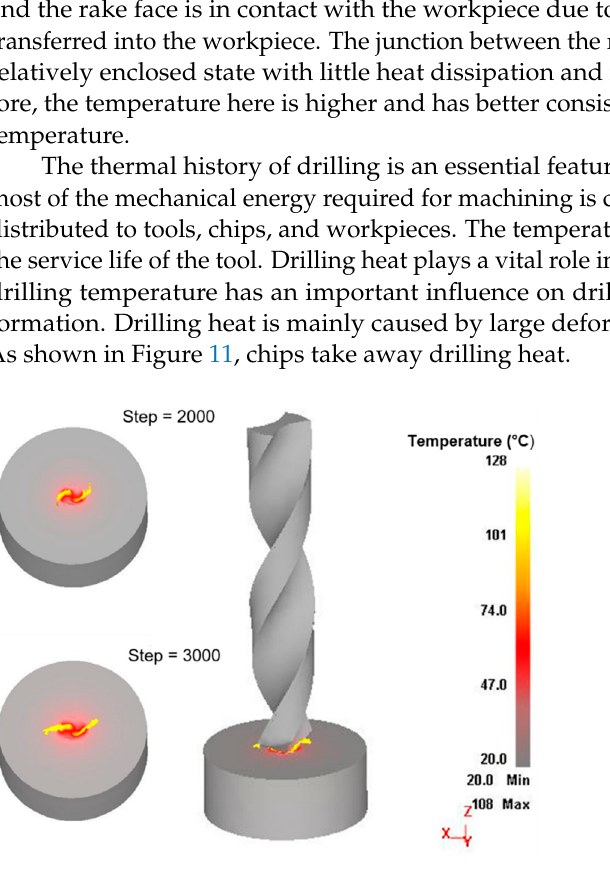
Figure 11. Temperature transfer during drilling.